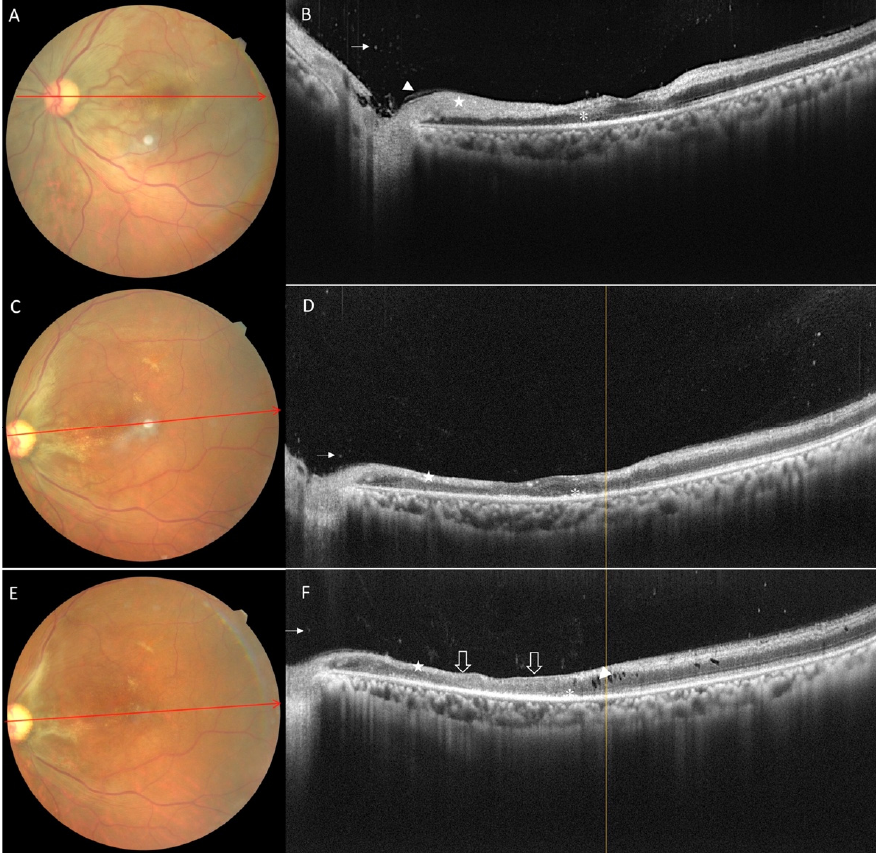
Figure 2. Serial fundus photographs and SD-OCT images of a patient (case 1) with delayed retinal imaging due to early debridement and associated morbidity. Imaging done at one week shows ( A ) Diffuse retinal whitening with cherry-red spot on fundus photography ( B ) the corresponding SD-OCT line scan shows increased inner retinal thickening and hyperreflectivity (white star), thinning of nasal retina at 1 mm from the fovea, vitreous cells overlaying the disc (white arrow), posterior hyaloid thickening and detachment (white arrowhead) and disruption of the photoreceptor layer and ELM (white asterisk). At the follow-up of four weeks ( C ) fundus photographs revealed improved retinal transparency with confinement of retinal opacification being to the parapapillary area. ( D )